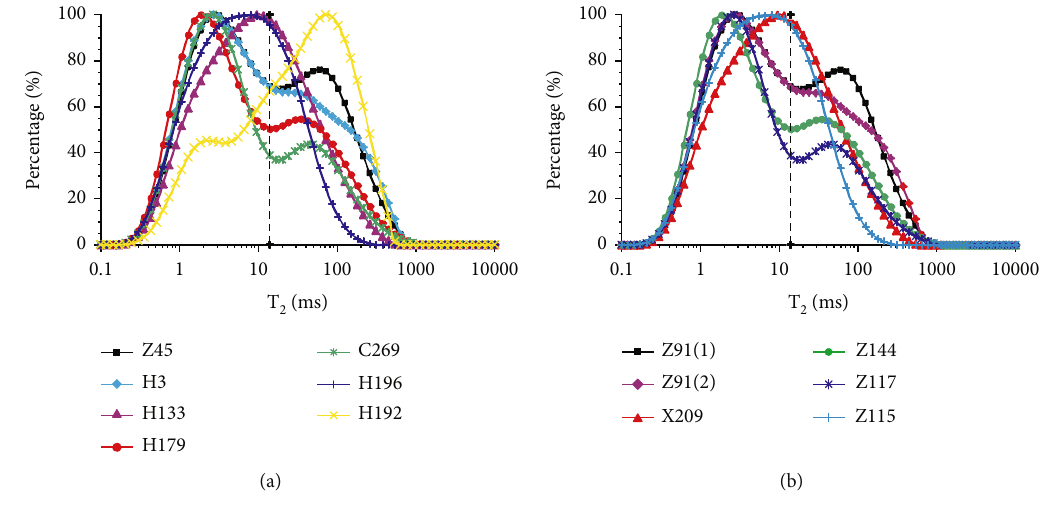
Figure 8: T 2 curves of the (a) Jiyuan and (b) Heshui